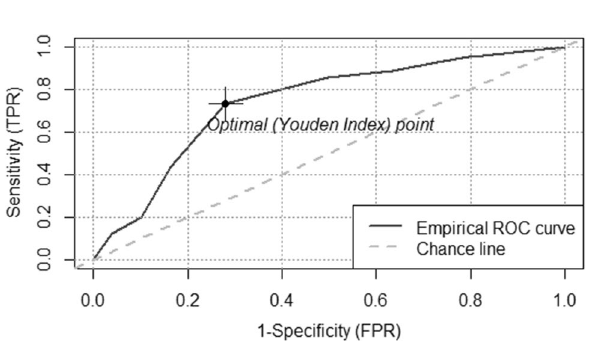
Figure 2. Receiver operating characteristic curve of MDD-W by using nutritional status as a benchmark of PLHIV in all Bahir Dar ART clinics, 2017 42 .